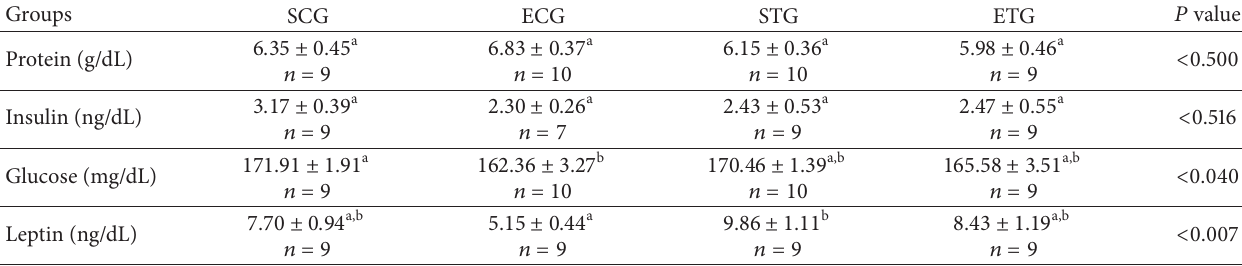
Table 4: Total protein, glucose, insulin, and leptin concentrations of the different groups on day 90.